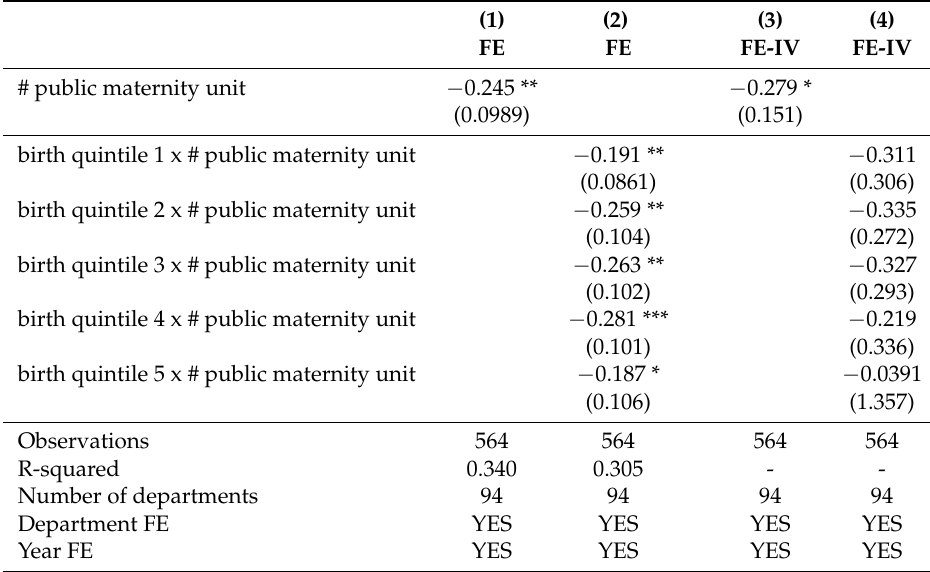
Table 3. Extensive margin substitution between maternity